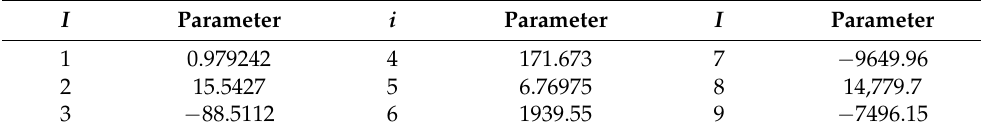
Table 5. Parameters for Equation